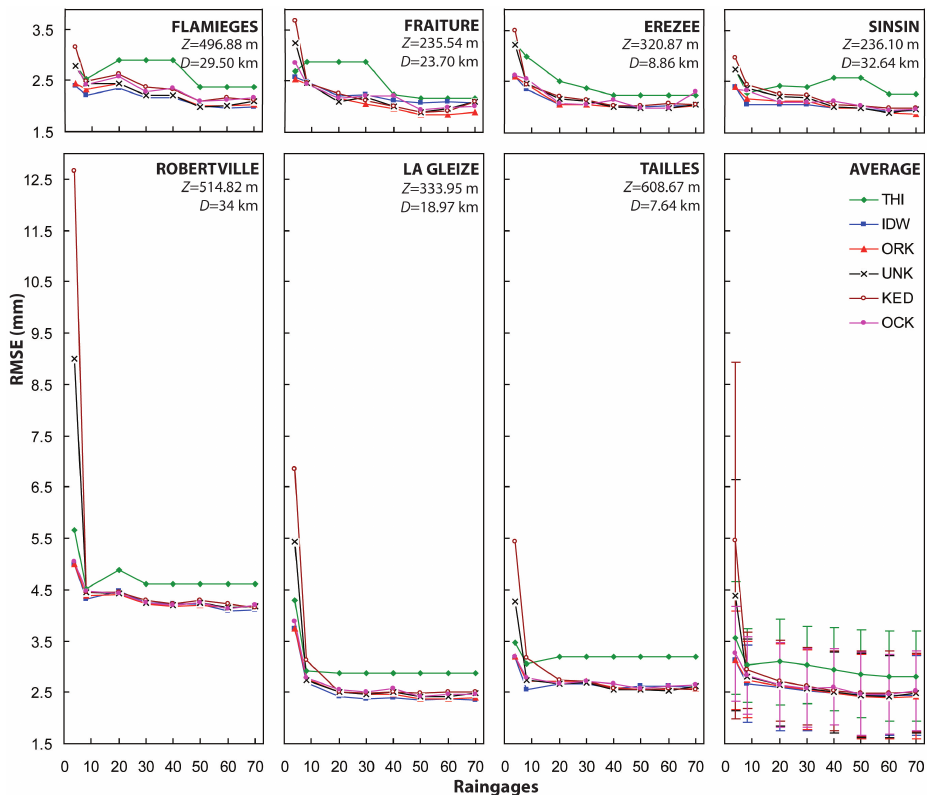
Fig. 10. Evolution of RMSE values of different methods and validation gages according to number of gages used for the spatial interpolation: the points (low-right) are the mean and error bars are plus and minus standard deviation of the seven validation raingages; Z is the elevation of the raingages; D is the distance from the raingages to the centre of the two